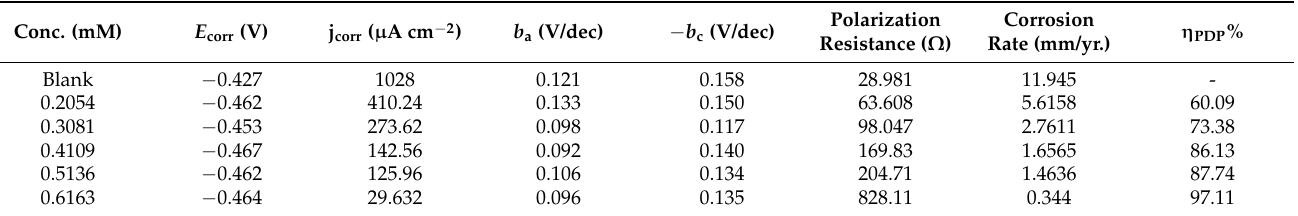
Figure 6. Tafel plots for mild steel for blank and varying doses of CMEA at 30 °C in 1 M HCl. Table 4. PDP parameters for MS corrosion in 1 M HCl in the absence and presence of various doses of CMEA at 30 ◦